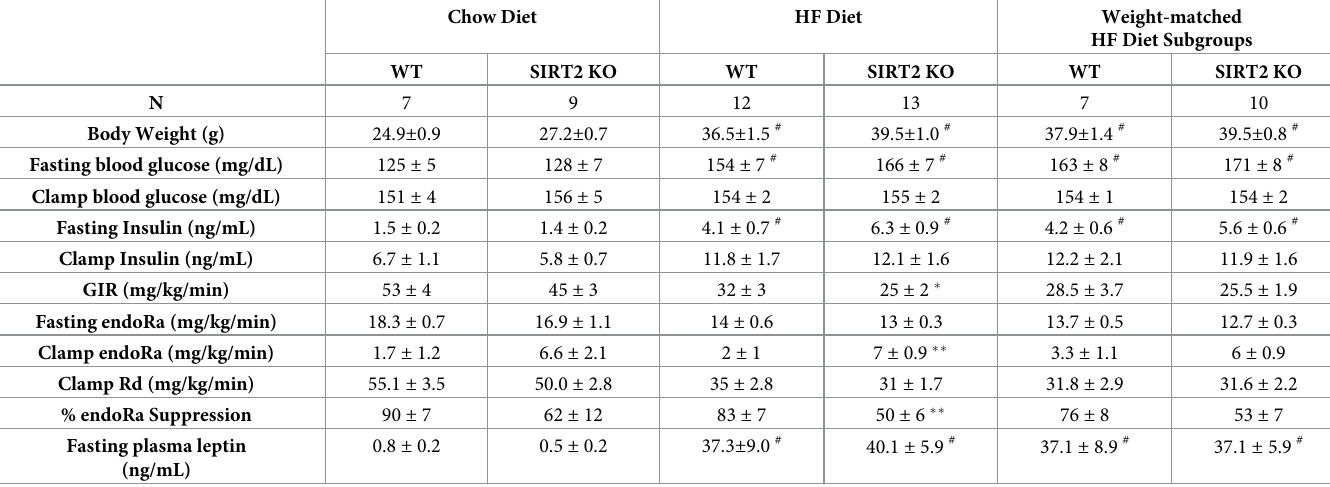
Table 1. Characteristics of the clamped WT and SIRT2 KO mice on a chow or HF